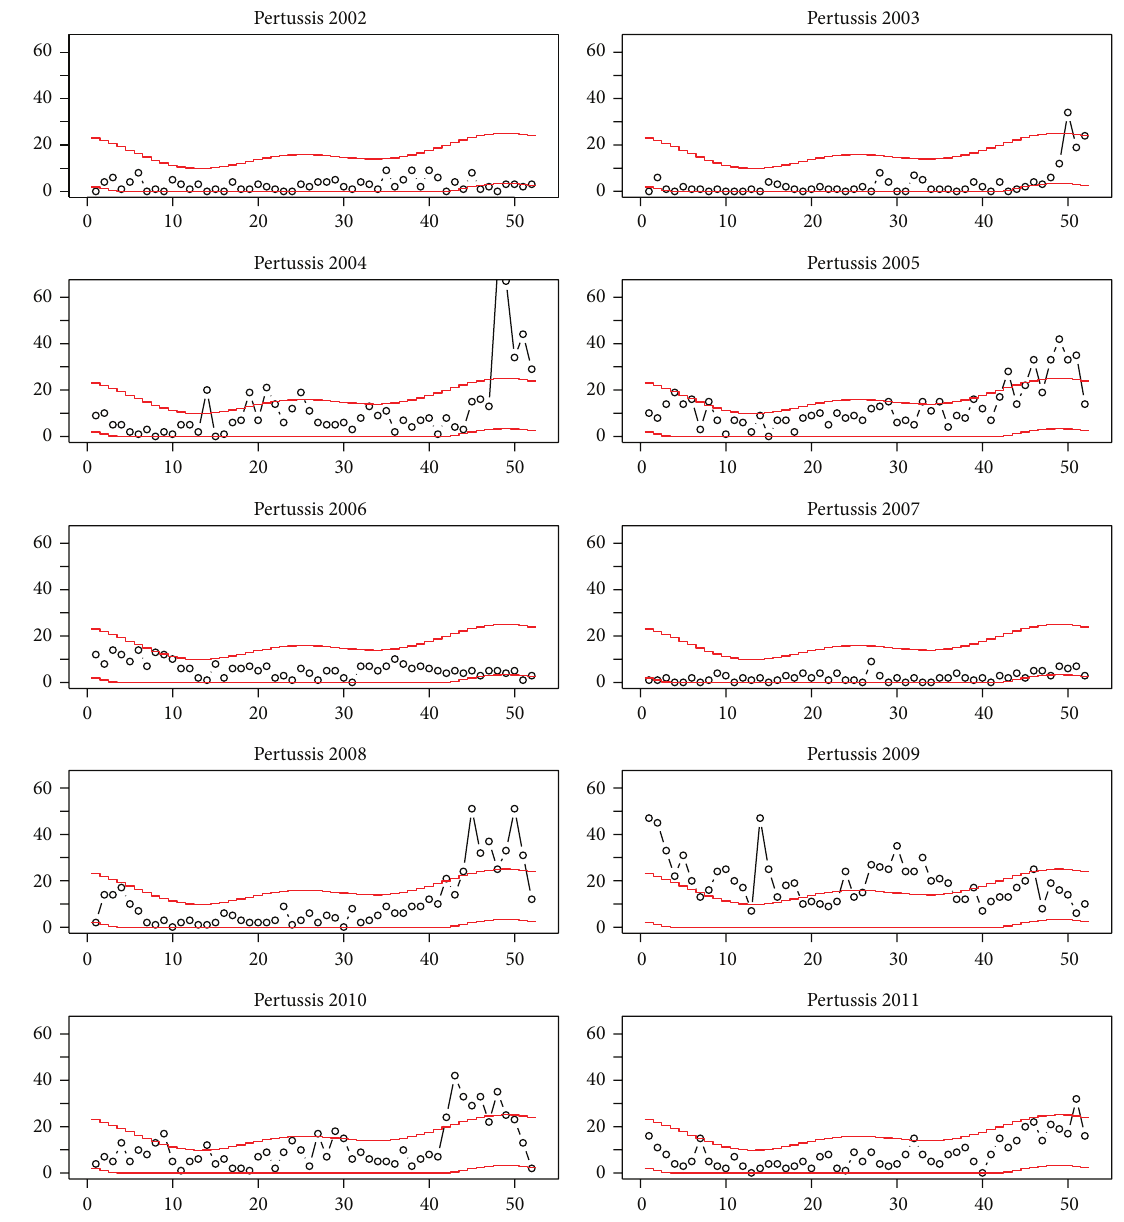
Figure 1: Weekly Pertussis cases, 2002–2011, Missouri,